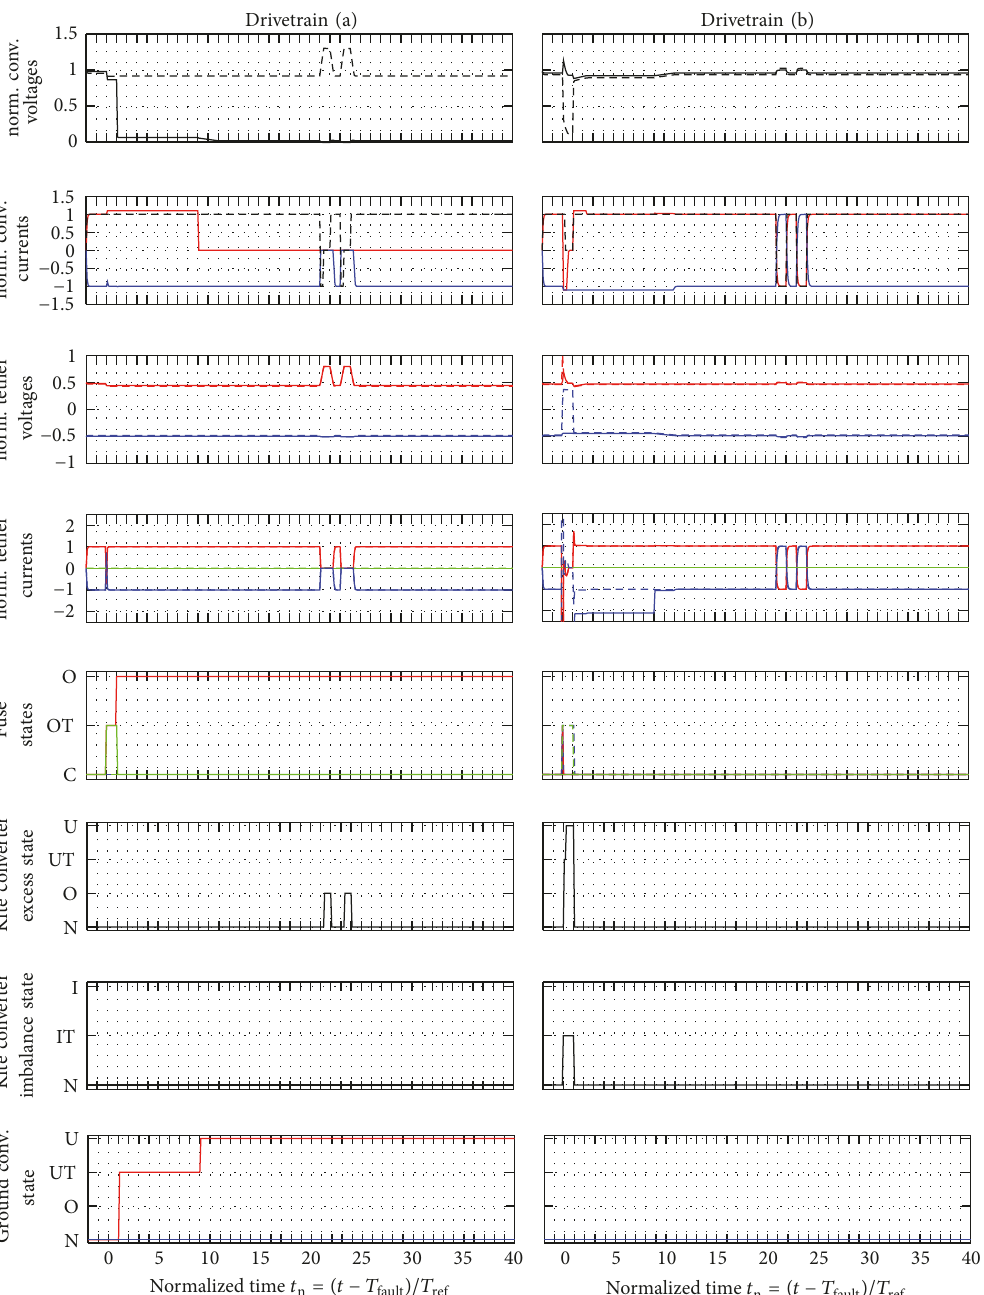
Figure 23: Simulated voltages, currents, and states for short circuit fault S21 in motor mode, with the same colors as in Figure 18, but additionally with (row 8) state of positive (red) and negative (blue) ground converters.